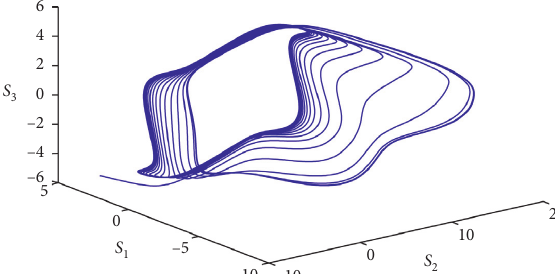
Figure 5: The phase plot of the leader for Example